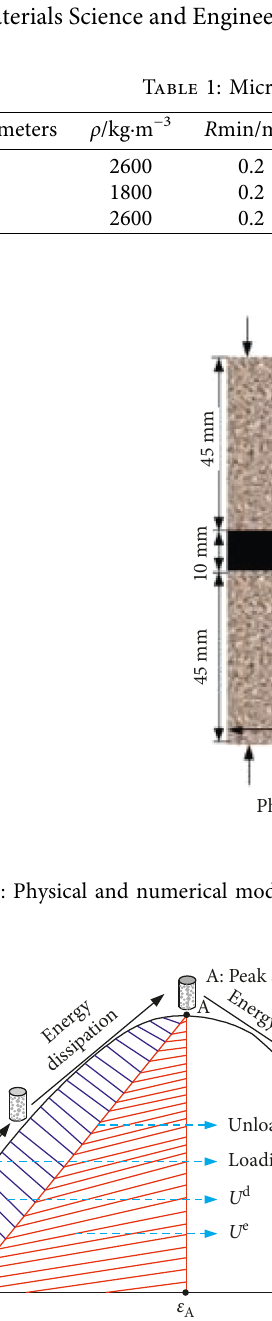
Figure 2: Relationship between dissipated energy and releasable strain energy in rock [5, 24].